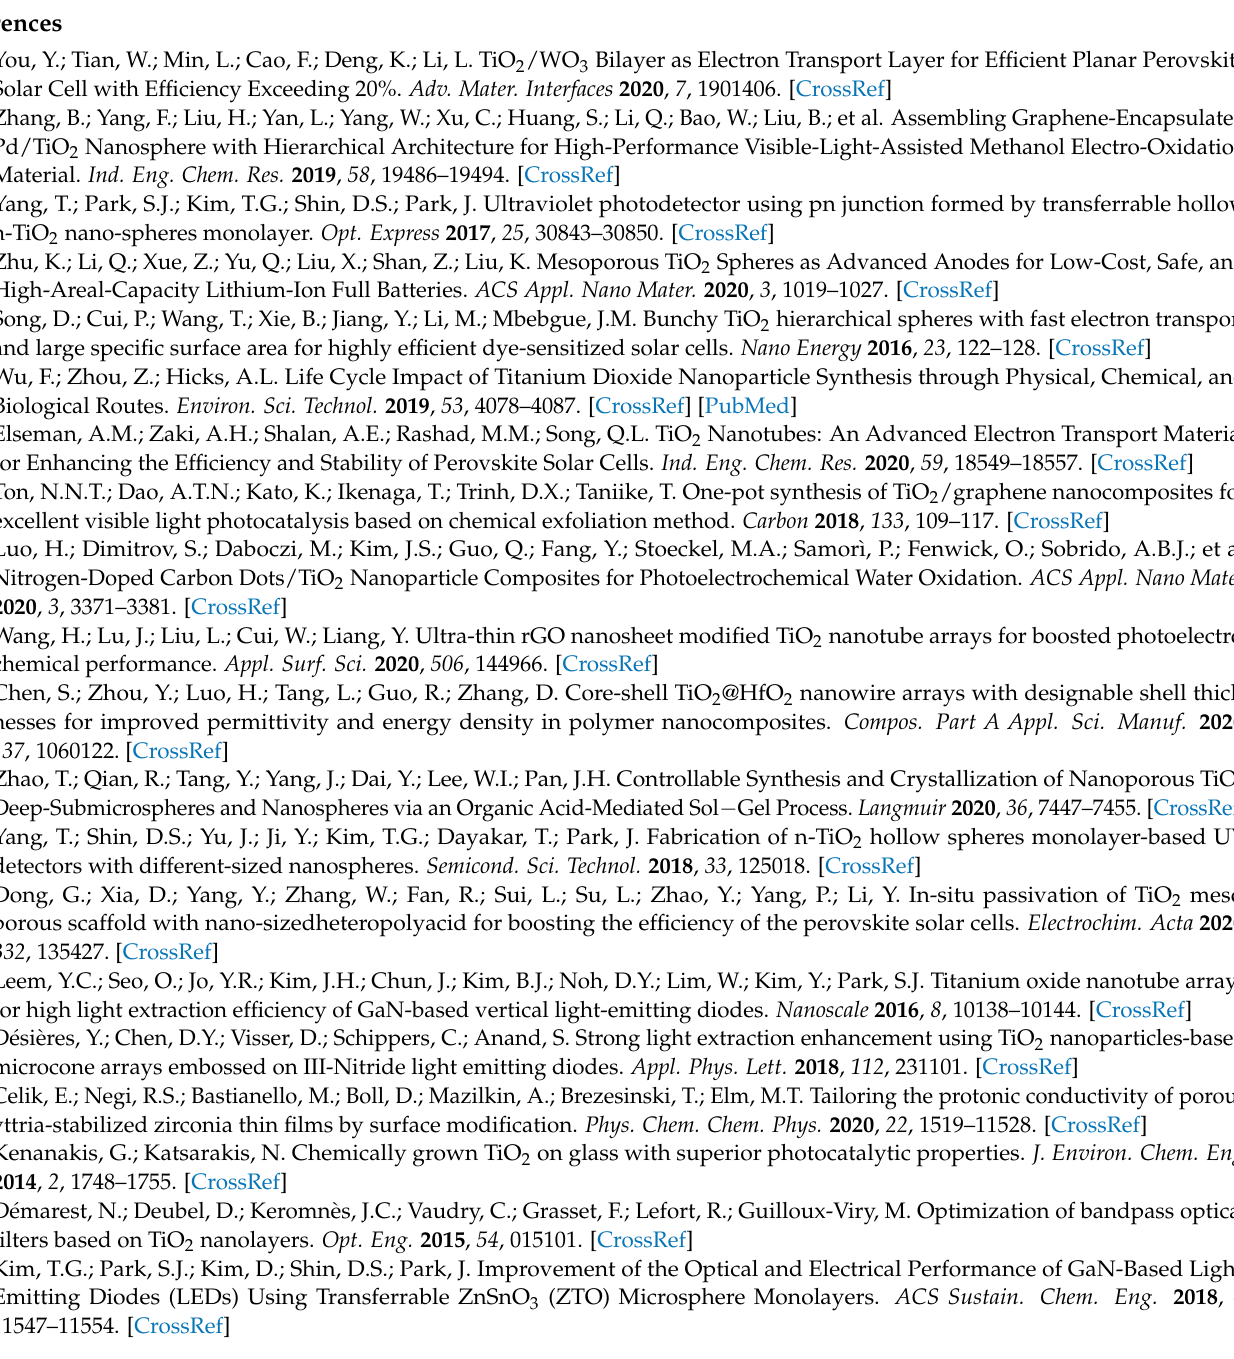
TiO 2 single sphere cross section image; Table S1: Summary of synthesized TiO 2 nanospheres sizes according to amount of the injected